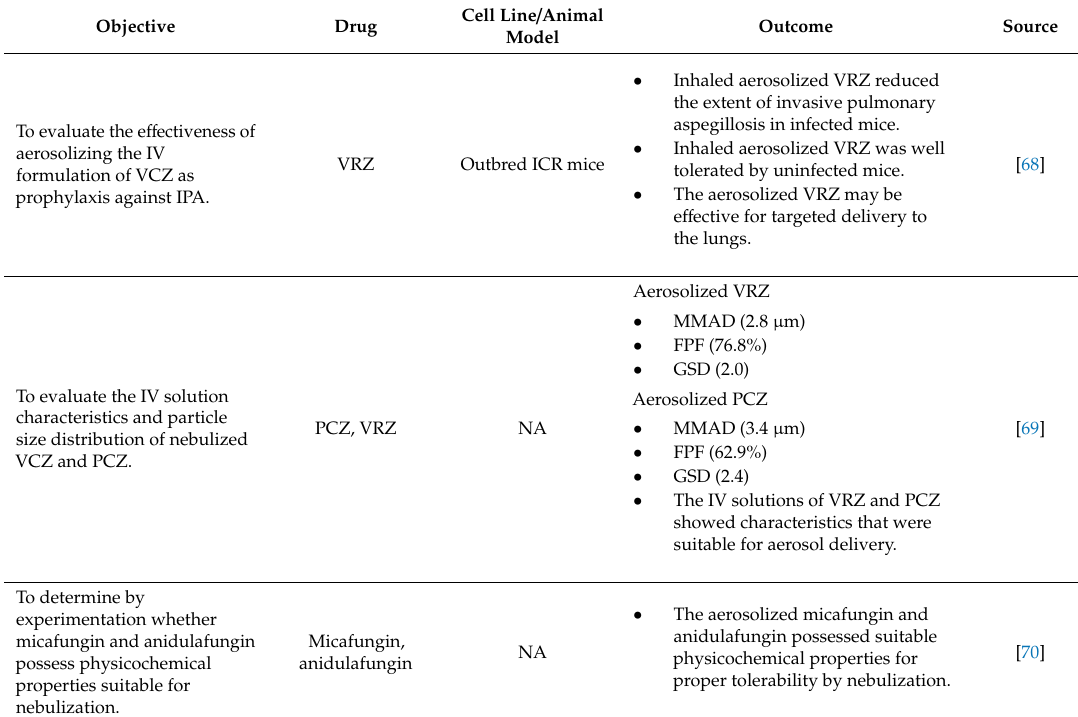
Table 3. Aerosolized intravenous formulation for nebulization against pulmonary